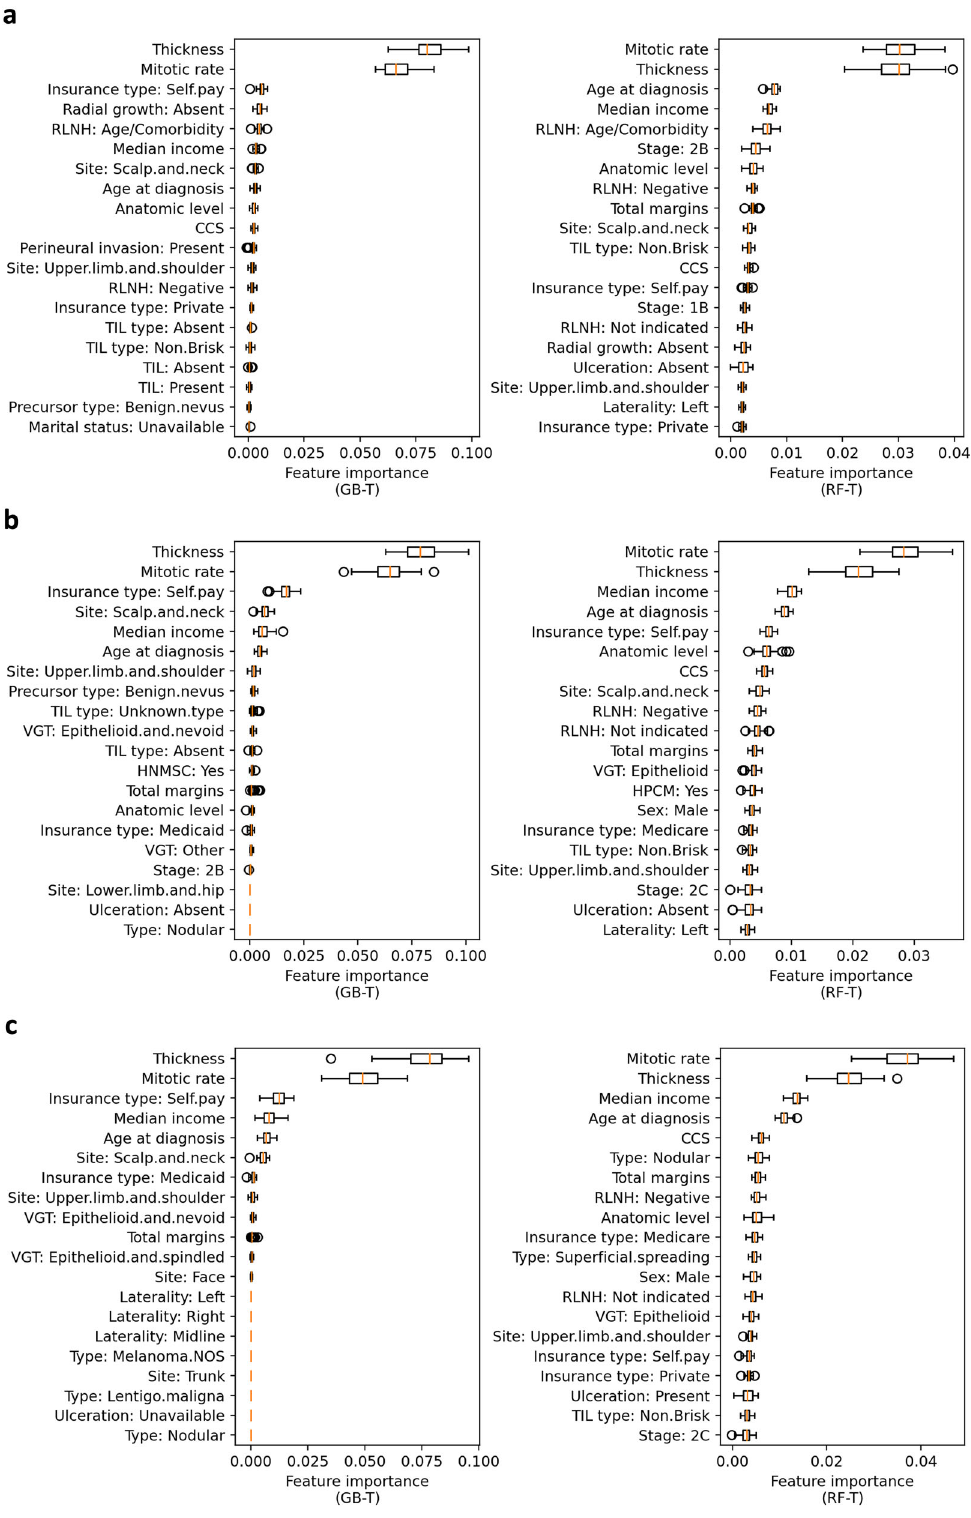
Fig. 7 Feature importance in time-to-event recurrence prediction by RF-T and GB-T models. a The 20 most important features when experimenting on the original cohorts. b The 20 most important features when experimenting on the core complete cohorts: negative or not indicated regional lymph node histology, known mitotic rate, and known ulceration. c The 20 most important features when experimenting on the complete cohorts: negative or not indicated regional lymph node histology, known median income, and all tumor features available. The box extends from the fi rst quartile to the third quartile of the feature importance values for each feature, with a line at the median. The whiskers extend from the box by 1.5x the interquartile range. Flier points are those past the end of the